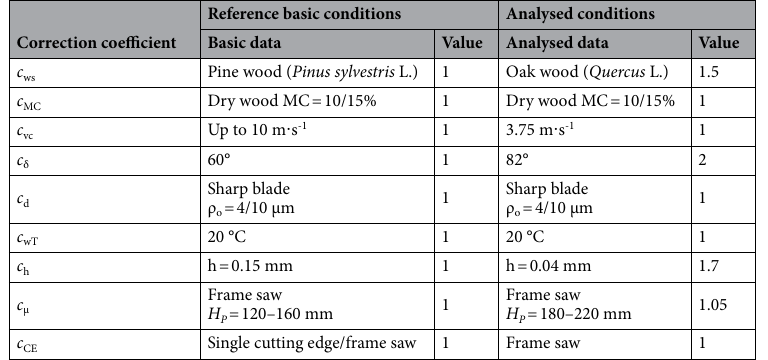
Table 3. Correction coefficients for the analysed cutting process conditions.